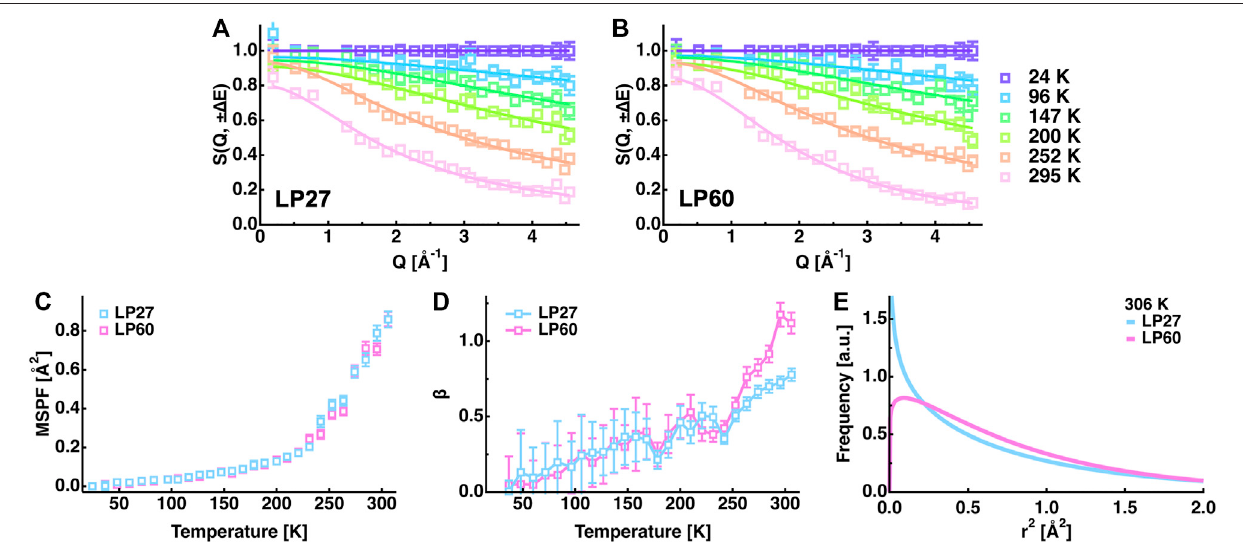
FIGURE6| SummaryoftheMSPFanalysis. (A,B) :EINScurvesofLP27 (A) andLP60 (B) asafunctionofQ.Thetemperaturesofthesecurvesare24,96,147,200, 252, and 295 K (from top to bottom). The corresponding fi ts by Eq. 2 in the text are shown by solid lines. (C) : MSPF values as a function of temperature. Those of LP27 and ofLP60 aredenoted bycyanand magenta open squares, respectively. Thesamecolornotationisused in (D,E) . (D) : Themeasure ofmotional homogeneity( β ) as a functionoftemperature. (E) :Distributionofthesquaredamplitudesofatomicmotionsat306 KobtainedbytheMSPFanalysis.Inallthepanels,errorbarsarewithin the symbols if not